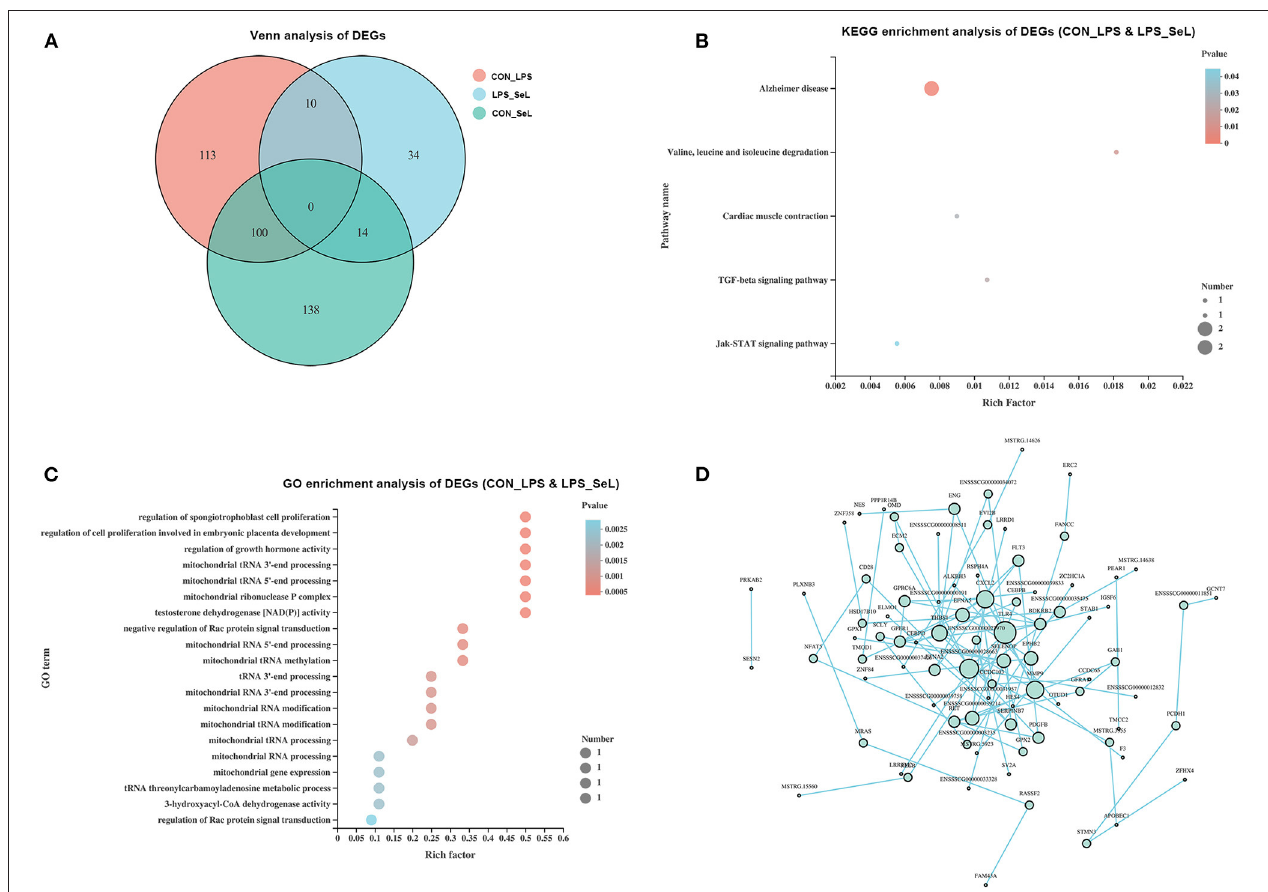
FIGURE 2 | Functional annotation of DEGs affected by both Se treatment and LPS infection. Venn diagram presenting co-expressed and uniquely expressed DEGs in the CON_LPS, LPS_SeL, and CON_SeL groups (A) . The KEGG (B) and GO (C) enrichment analysis of DEGs affected by both Se treatment and LPS infection was indicated. PPI was performed to generate interaction analysis (D) . Node color from white to green represents the lowest to highest betweenness centrality. The size of each node corresponded to the number of connections